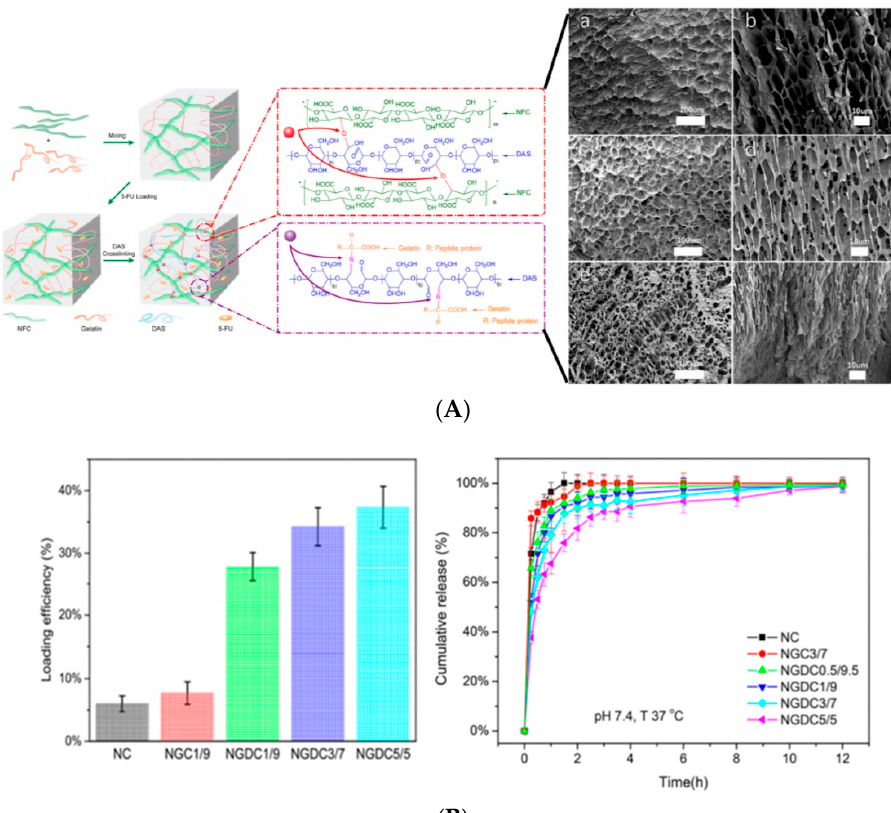
Figure 14. ( A ) Synthesis pathway and morphological structure of different ratio of NFC/Gelatin R NFC/Gelatin : ( a , b ) NGDC1/9; ( c , d ) NGDC3/7; ( e , f ) NGDC5/5. Surface ( a – c ); cross-section ( b , d , f ); ( B ) the influence of morphological structure of NFC/Gelatin Cryogel towards drug loading (left side) and release efficiency (right side) (This figure is reprinted with permission from [174]. Copyright © 2019 American Chemical Society).